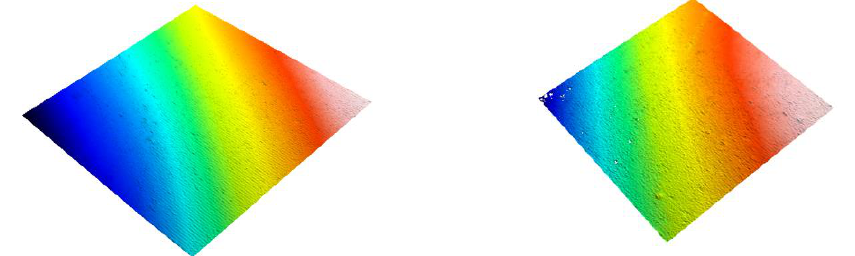
Figure 2. 3D image of Venus Diamond showing the surface of the resin-composite at baseline ( left image ) and after 20,000 cycles of toothbrushing abrasion ( right image )